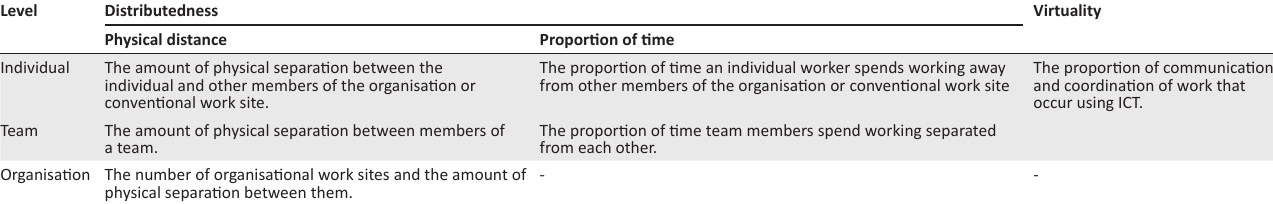
TABLE 9: Organisational levels connected with distributedness and virtuality.